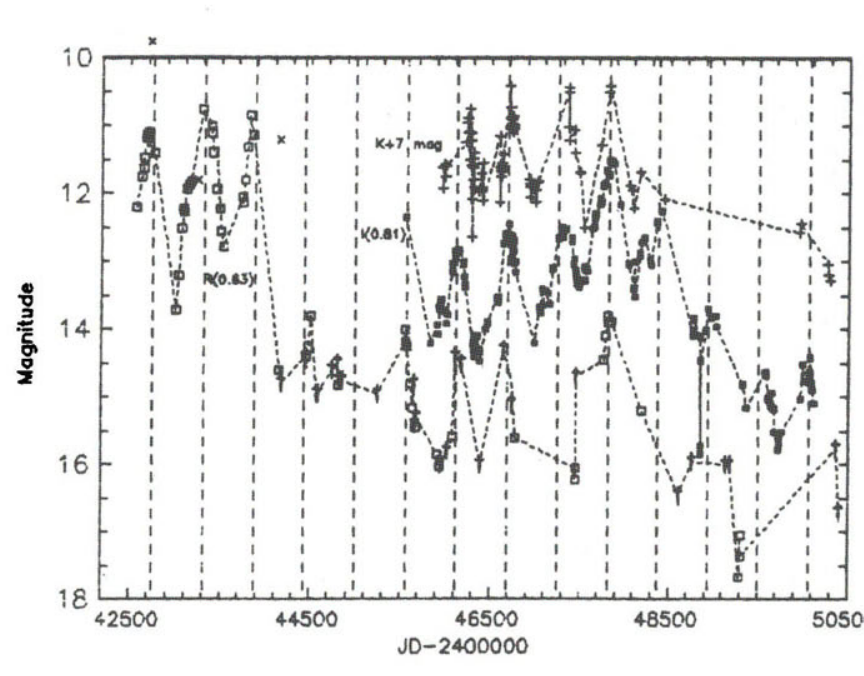
Fig. 1. Light curves of V366 Lac in the red, photographic infrared and infrared K passband. Open squares are R (0.63) magnitudes, daggers designate their limiting magnitudes, filled squares are 7(0.81) magnitudes, crosses are K magnitudes + 7 mag, diagonal crosses are the same but for Gezari et al. (1993). Vertical dashed lines are times of calculated maxima: JD2442753 + 562.5